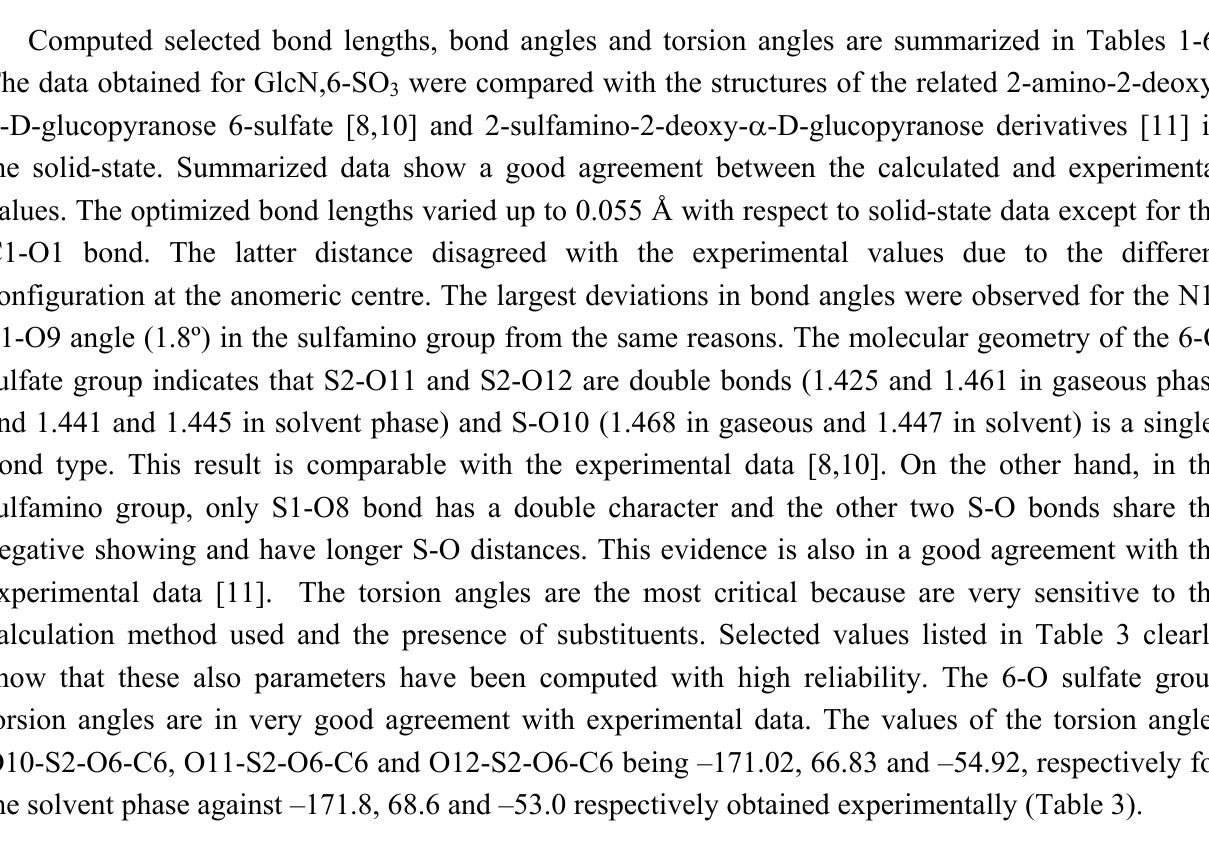
Table 1. Selected optimized calculated and experimental bond lengths for GlcN,6-SO